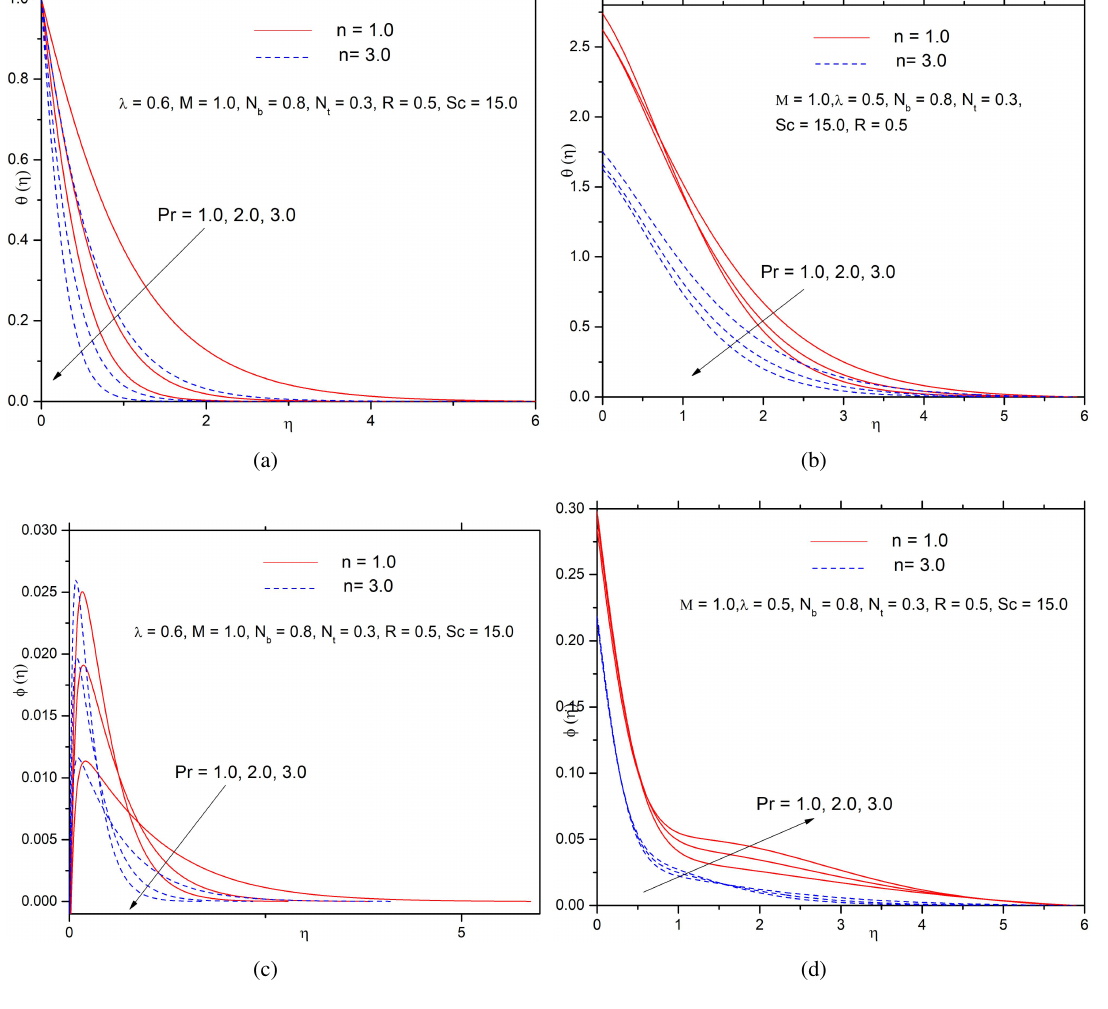
Fig. 7 Influences of Pr, Prandtl number on θ ( η ) , temperature for (a) CWT and (b) PHF and on ϕ ( η ) , nanoparticle volume fraction for (c) ZMF and (d)